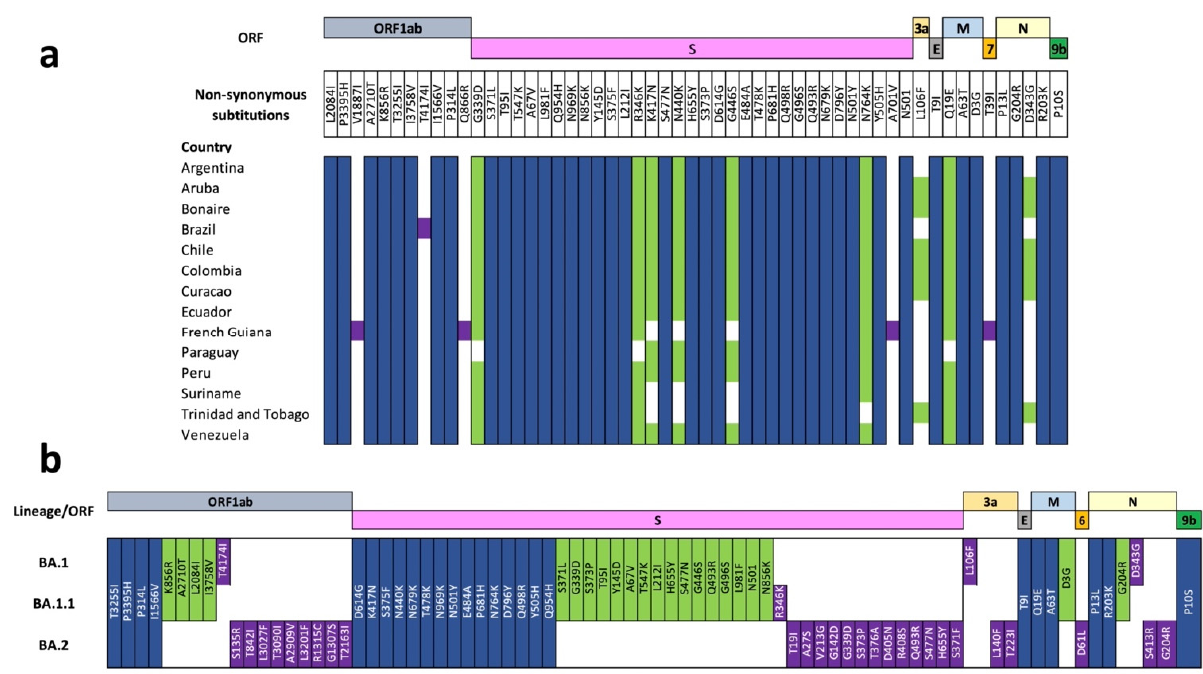
Figure 2. Nucleotide diversity of analyzed Omicron genomes. The figure represents the non-synonymous amino acid substitutions found in the 21,615 SARS-CoV-2 whole-genome sequences compared with the Wuhan reference sequence (NC_045512.2). ( a ) Mutational analysis between South American countries. ( b ) Mutational analysis between Omicron sublineages (BA.1, BA.1.1 and BA.2). For both analyses, substitutions found in more than 10% of the genomes analyzed were considered. The blue color represents the substitutions shared between the 21,615 genomes analyzed, the green color represents the substitutions found in the genomes of some countries, and the purple color represents the substitutions considered unique for each country.